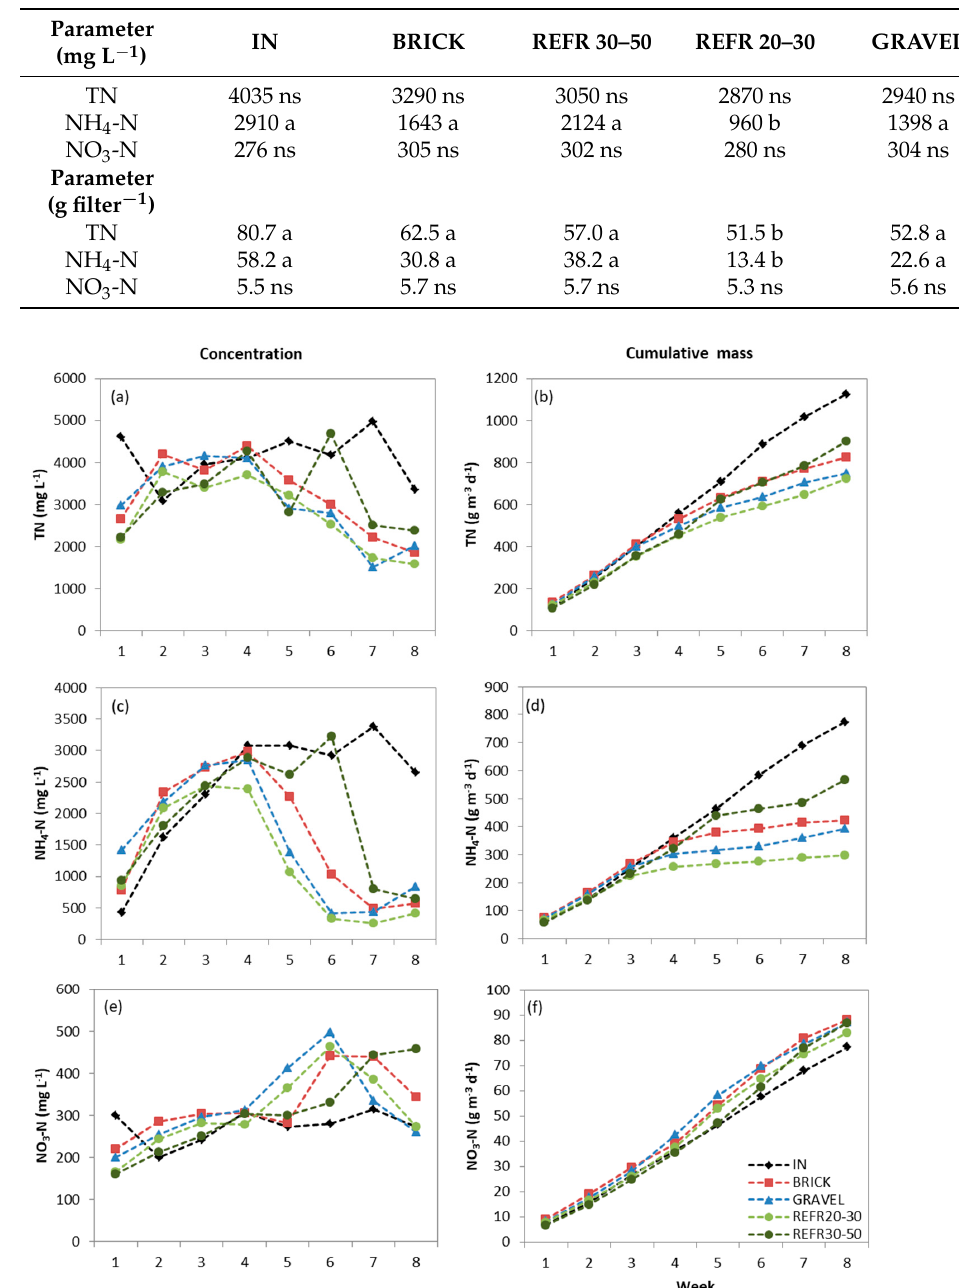
Table 3. The eight-week median values of total nitrogen (TN), ammonia–nitrogen (NH 4 -N), and nitrate–nitrogen (NO 3 -N) at the inlet (IN) and filter outlets. Different letters indicate significant differences at p < 0.05 by Kruskal–Wallis test. ns: not significant.